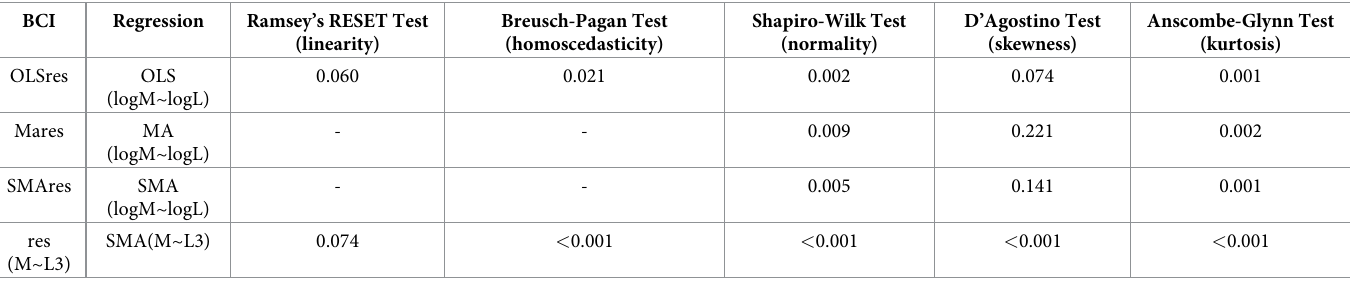
Table 3. Tests of the assumptions of regression-based body condition indices. We tested three assumptions, whether 1) data are linear, 2) variance is constant (i.e., homoscedastic), and 3) frequency distribution of residuals are normal. Only p-values are reported. BCI